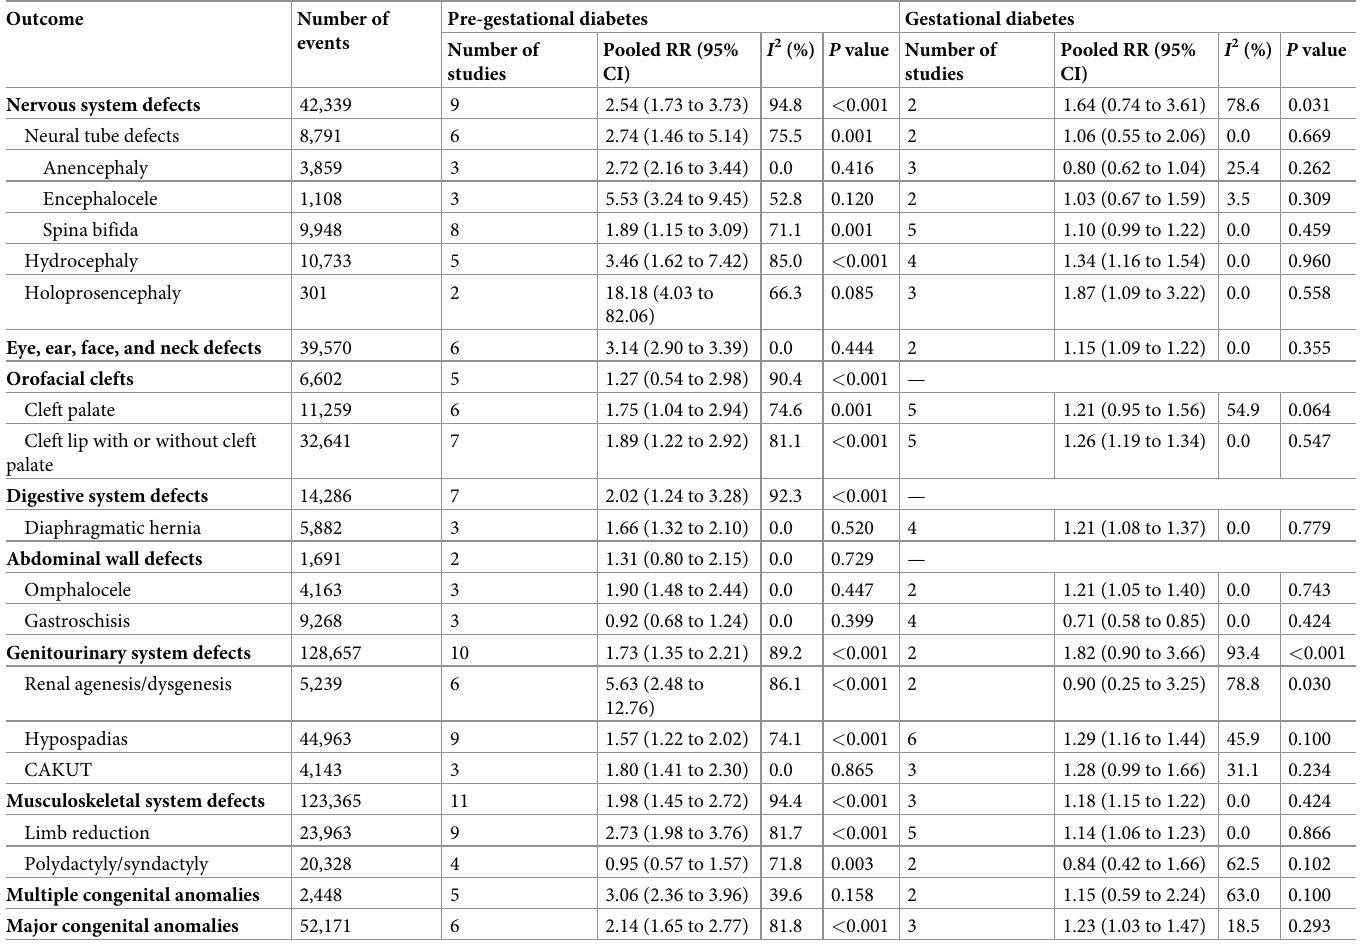
Table 3. Pooled RRs and 95% confidence intervals for associations between maternal diabetes and other type-specific congenital